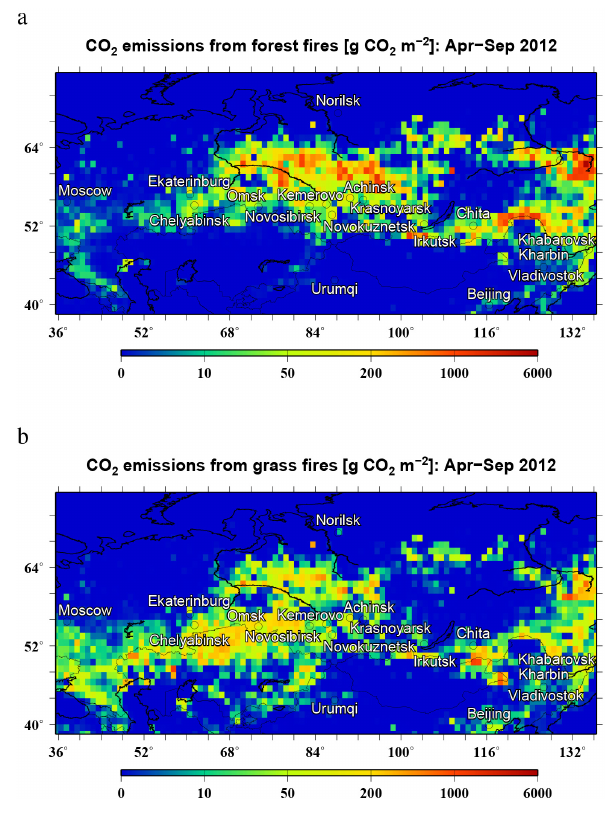
Figure 4. CO 2 biomass burning emissions (gCO 2 m − 2 ) from (a) forests and (b) from other types of vegetative land cover (mainly grasslands): mean values estimated in this study for the period from April to September